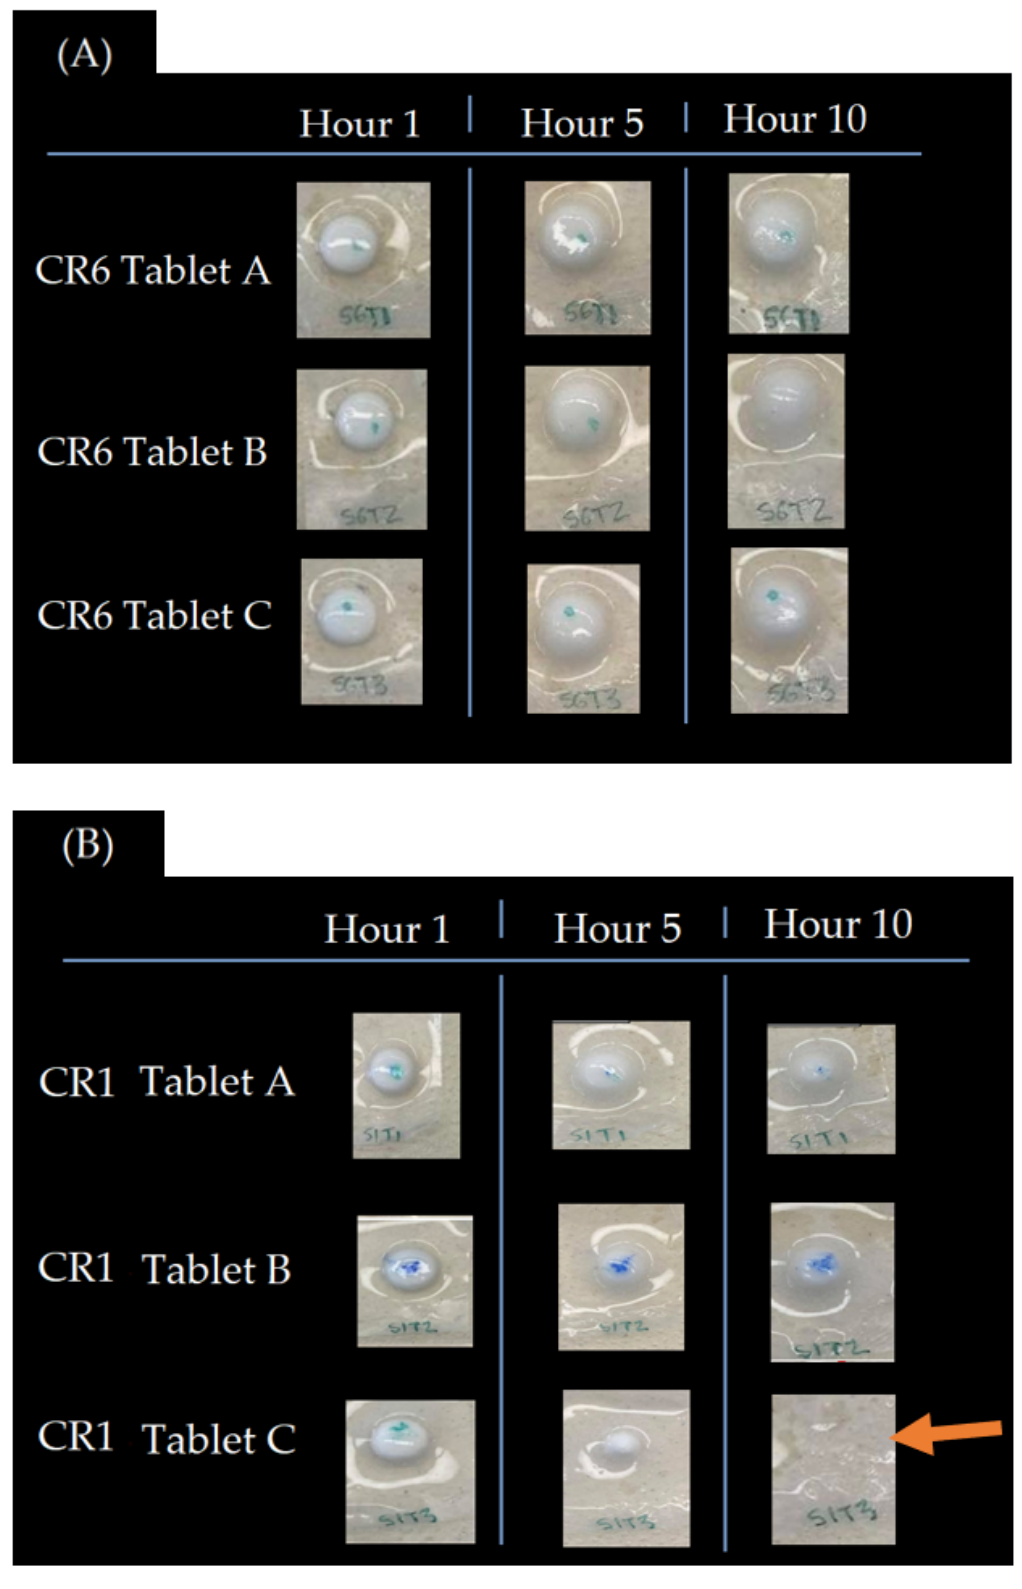
Figure 9. Formulation CR6 ( A ) and CR1 ( B ) after 1, 5 and 10 h of being submerged in PSVF. Uneven tablet erosion is evident between CR1 triplicates ( B ), as indicated by the arrow.